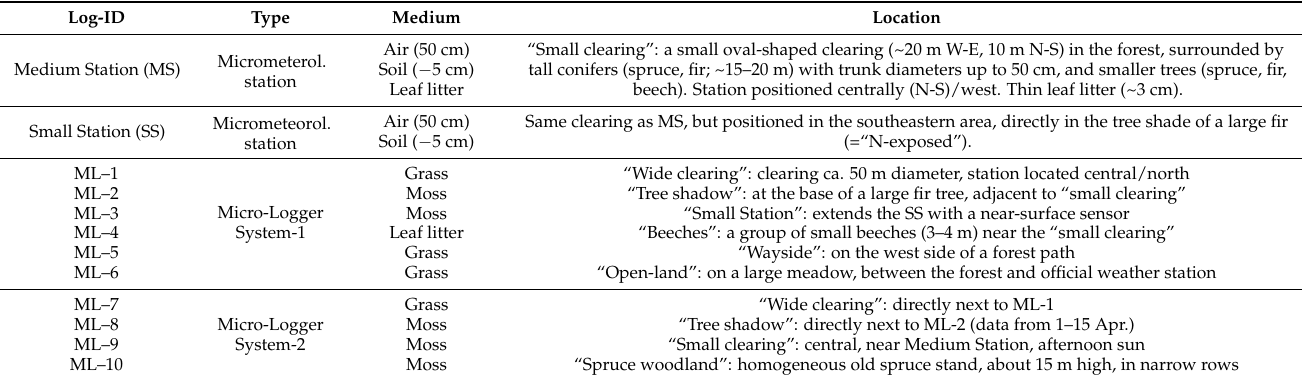
Table 1. Description of the micro-meteorological stations (MS, SS) and near-surface Micro-Loggers (ML) within the forest. Log-ID Type Medium Location Medium Station (MS) Micrometerol. station Small Station (SS) Micrometeorol. station